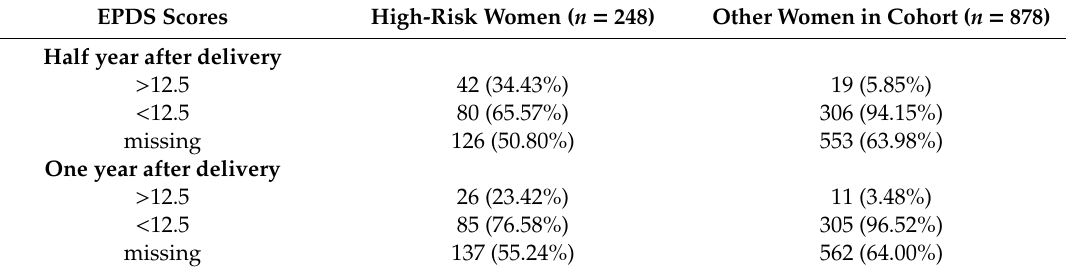
Table A1. Follow-up about depression of women in the